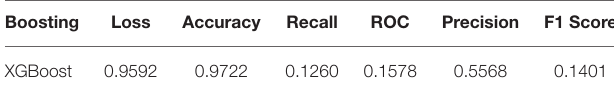
TABLE 3 | Performance metrics values of XG-Boost with one